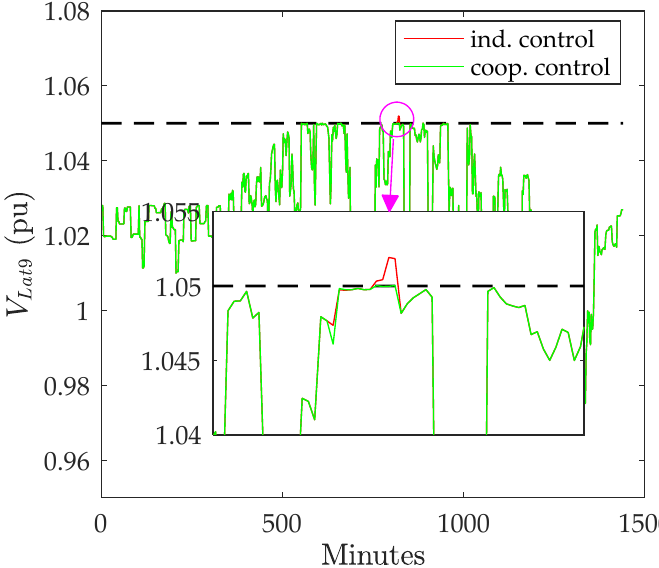
Figure 19. Voltage on lateral 9 with individual control and cooperative control.